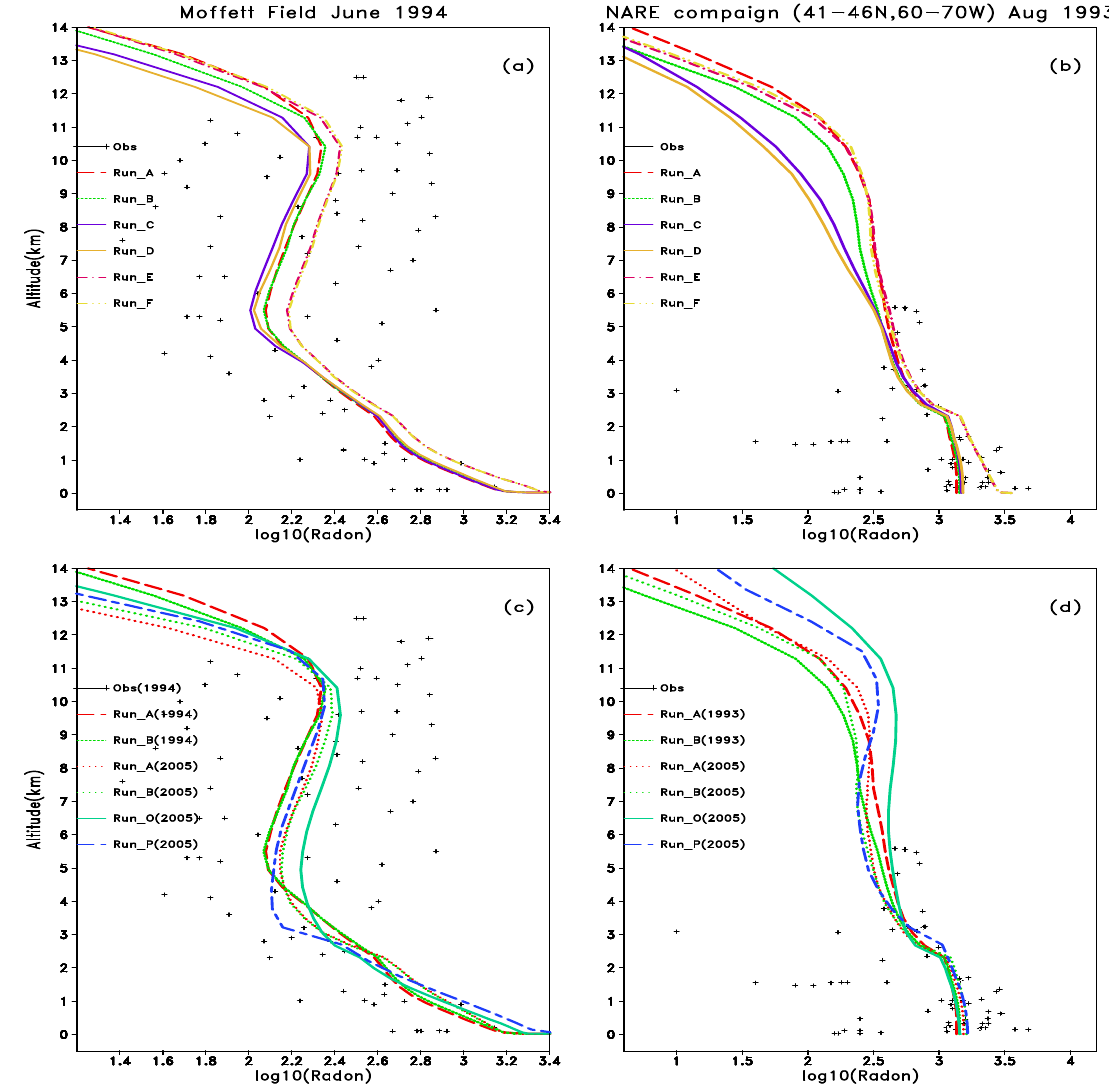
Fig. 14. Comparison of observed radon profiles (mBqm − 3 STP) at (a) Moffett Field in June 1994 and (b) NARE campaign in August 1993 with results from model runs “A E40”, “B EI”, “C E40noconv”, “D EInoconv”, “E EInewevap”, “F EInewconv” and “O EIar”. Panels (c) and (d) show the same two campaigns as (a) and (b) , respectively, along with model runs “A E40” and “B EI” but also include results from model runs “A E40”, “B EI”, “O EIar” and “P det” sampled for 2005.